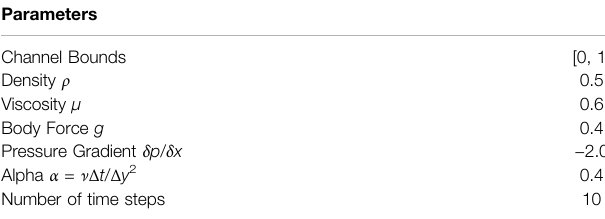
TABLE 2 | Flow parameters used for the channel fl ow.